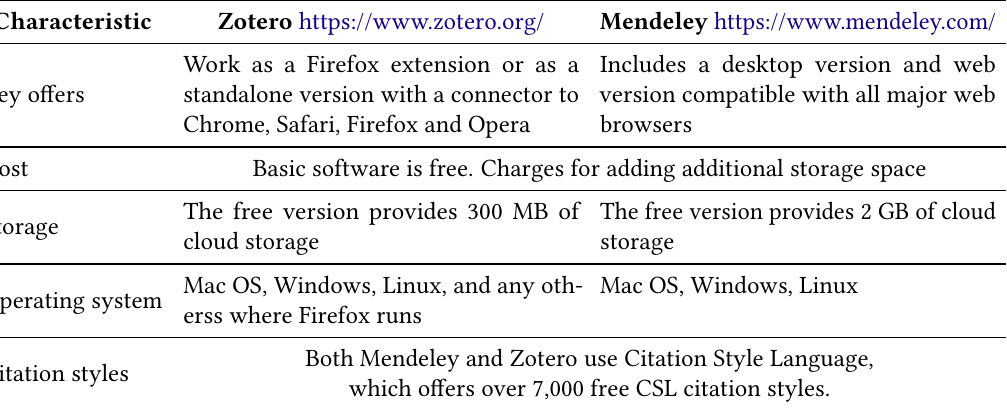
Table 3 Comparative analysis of bibliographic managers (source: